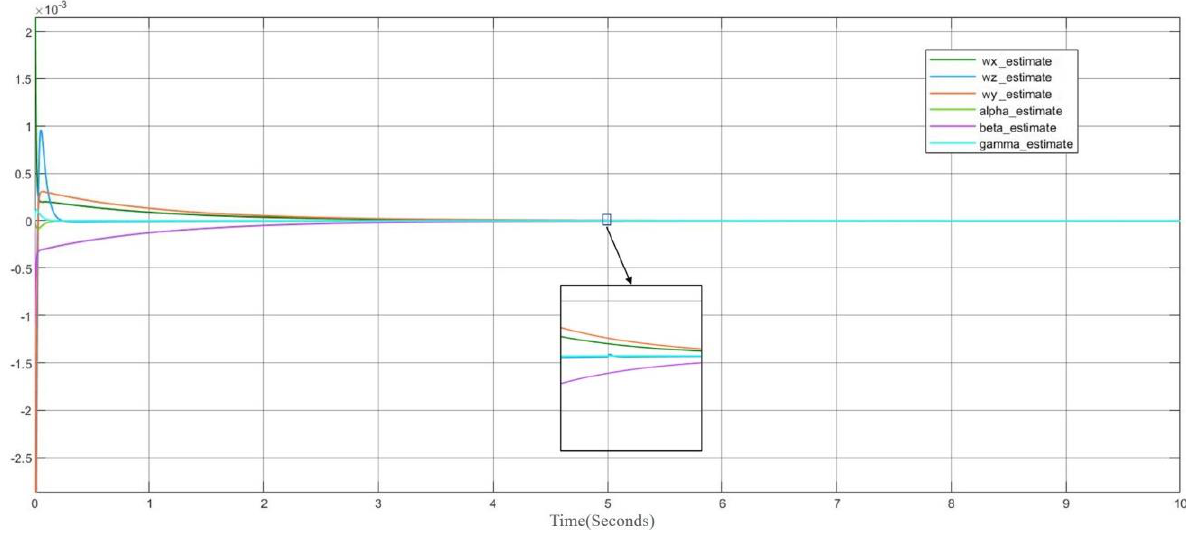
Figure 9. Input 2’s 20% PLOE fault detection simulation.